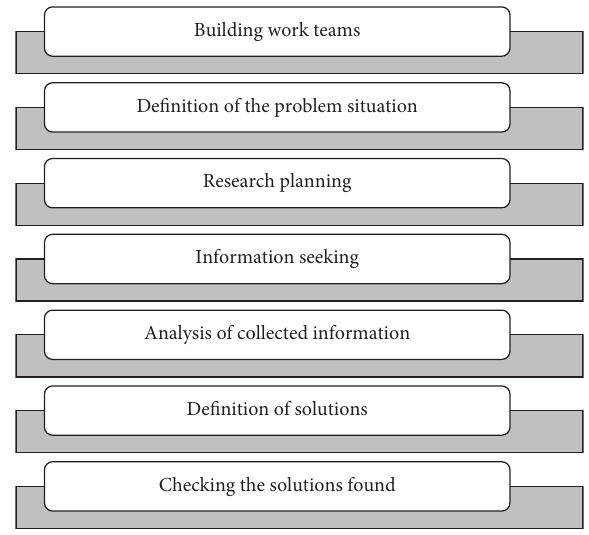
Figure 2: Phases of